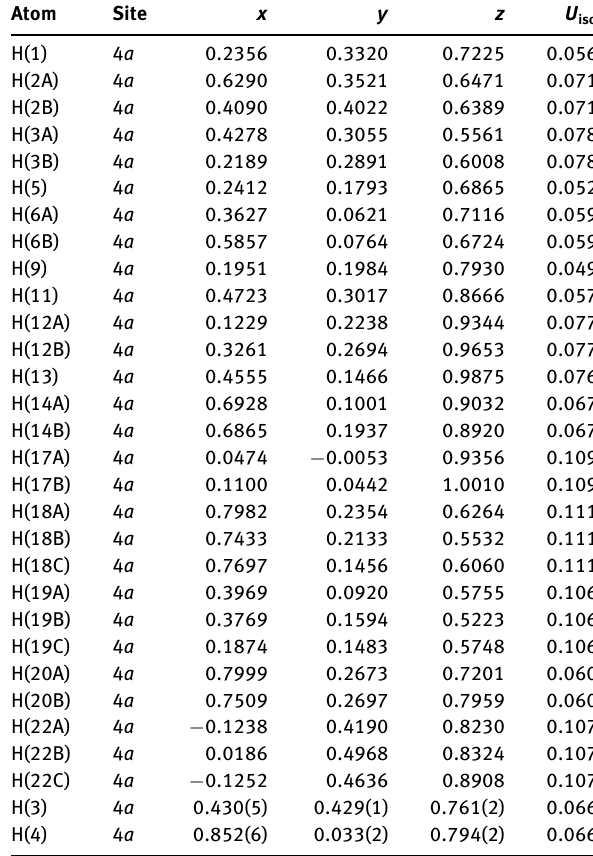
Table 2: Fractional atomic coordinates and isotropic or equivalent isotropic displacement parameters (Å 2